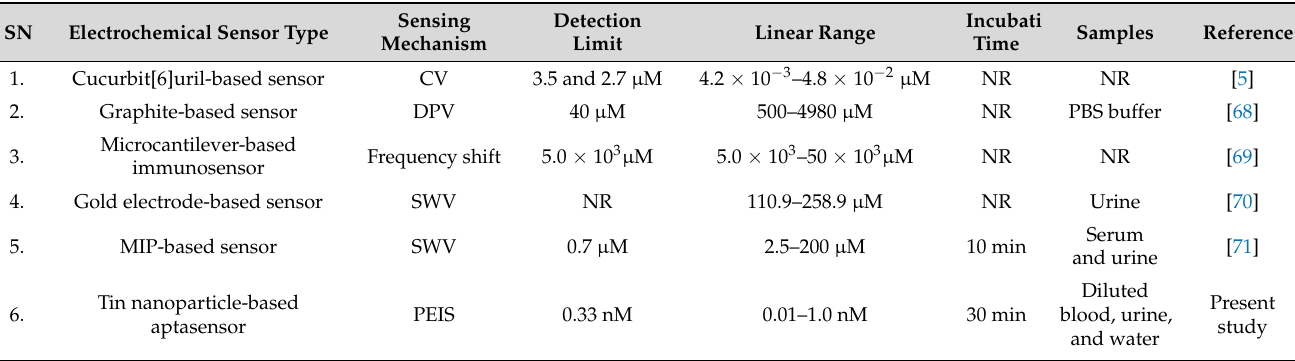
Table 2. Comparison of reported electrochemical sensors for MDMA detection.